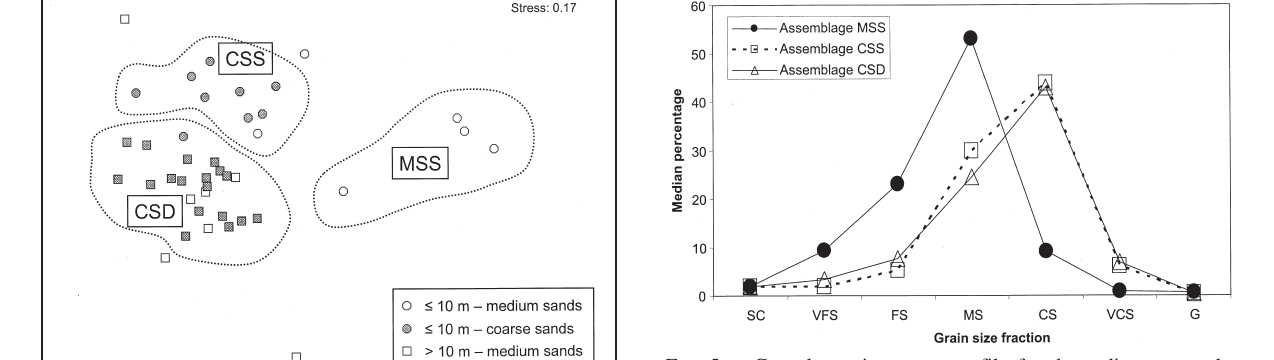
Fig . 5. – Granulometric master profile for the sediment samples belonging to each faunistic assemblage: (MSS (Medium Sand Shal- low), CSS (Coarse Sand Shallow) and CSD (Coarse Sand Deep)). G (Gravel): >2 mm, VCS (very coarse sand): 2.0-1.0 mm, CS (coarse sand): 1.0-0.5 mm, MS (medium sand): 0.5-0.25 mm, FS (fine sand) 0.25-0.125 mm, VFS (very fine sand): 0.125-0.063 mm; SC (silt- clay): <0.063